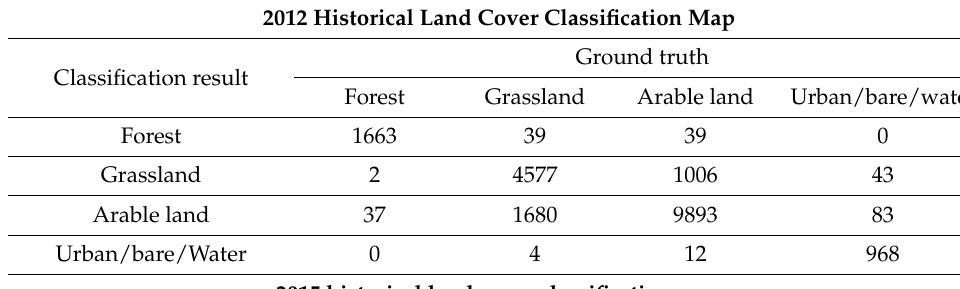
Table 1. Confusion matrix for the historical land cover classification maps of 2012 and 2015. 2012 Historical Land Cover Classification